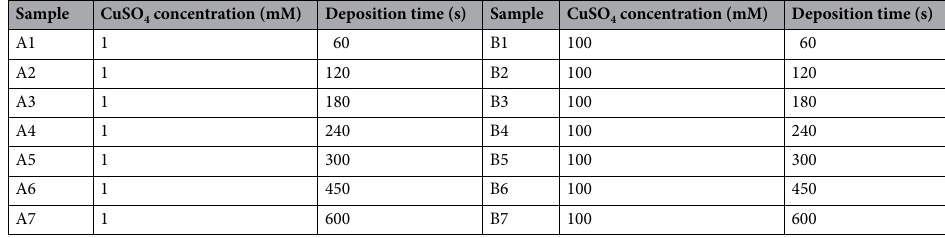
Table 1. The summary of the samples prepared in the process of